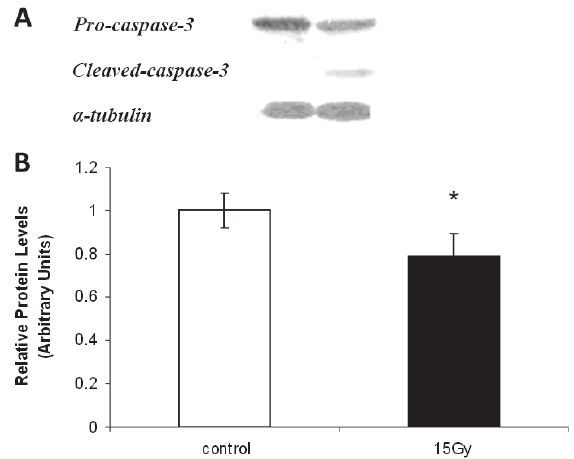
Fig. 2 - Difference in expression of the pro-caspase-3 proteins in the LV. Panel A , representative Western blotting. of pro-caspase-3. Panel B , densitometric analyses of the pro-caspase-3 blot. White bar represent control and black bar represent irradiated group. * p < 0.05.